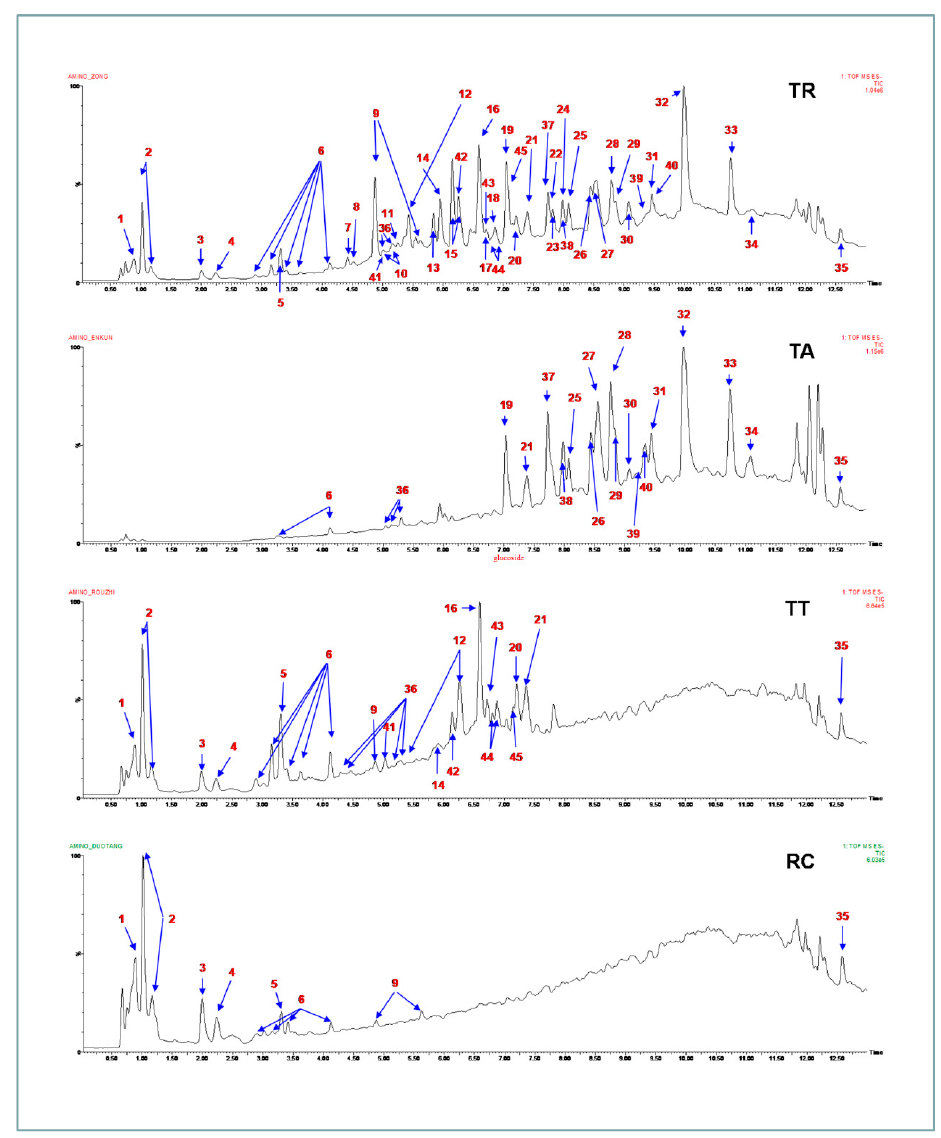
Figure 5. The total ion current chromatograms of each extract were analyzed by HPLC–QTOF-MS in negative ESI mode. Peak numbers are corresponding to compound types in Table 2.